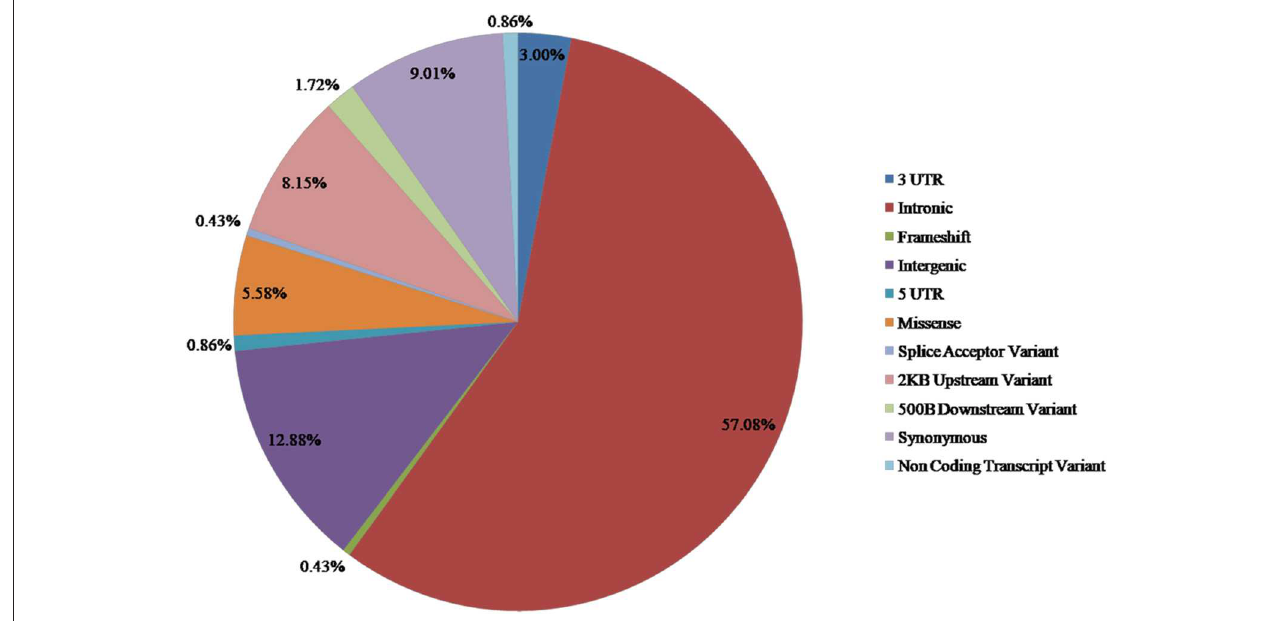
FIGURE 2 | Distribution of SNPs associated with antidepressant response in MDD.